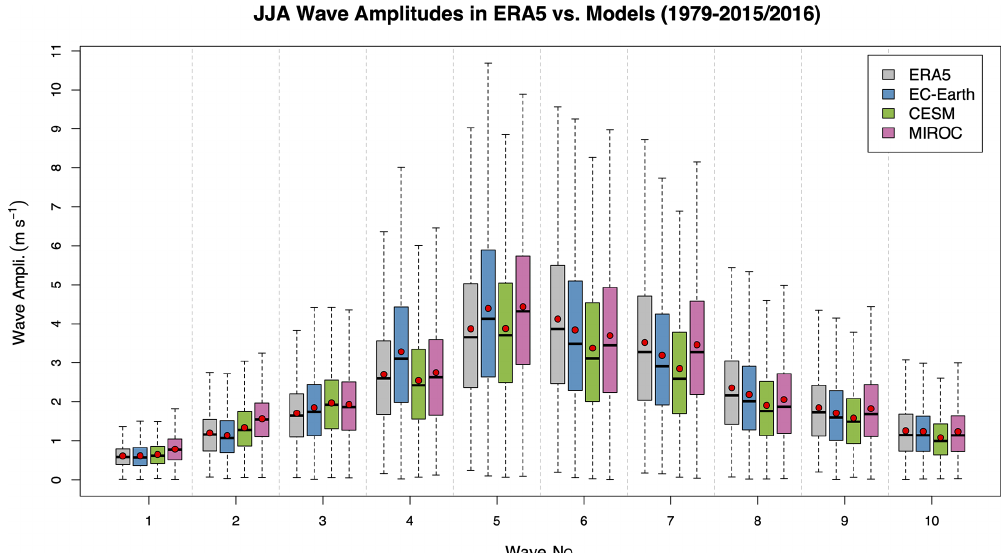
Figure 1. Boxplot for wave amplitudes in AISI climatology runs for climate models EC-Earth, CESM, and MIROC as well as reanalysis data ERA5 for the period of June, July, and August in 1979–2015/2016. Red dots indicate the mean, and thick black lines represent the median. The lower hinge of each box is the Q1 quartile (25th), and the upper hinge is the Q3 quartile (75th). The upper and lower bars are based on 1.5 times the interquartile range (IQR) value. The outliers are not shown in the